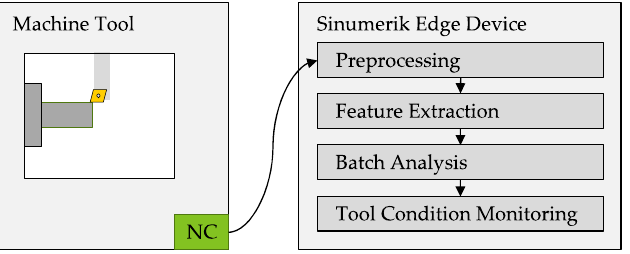
Figure 1. System overview for batch-aware tool condition monitoring.